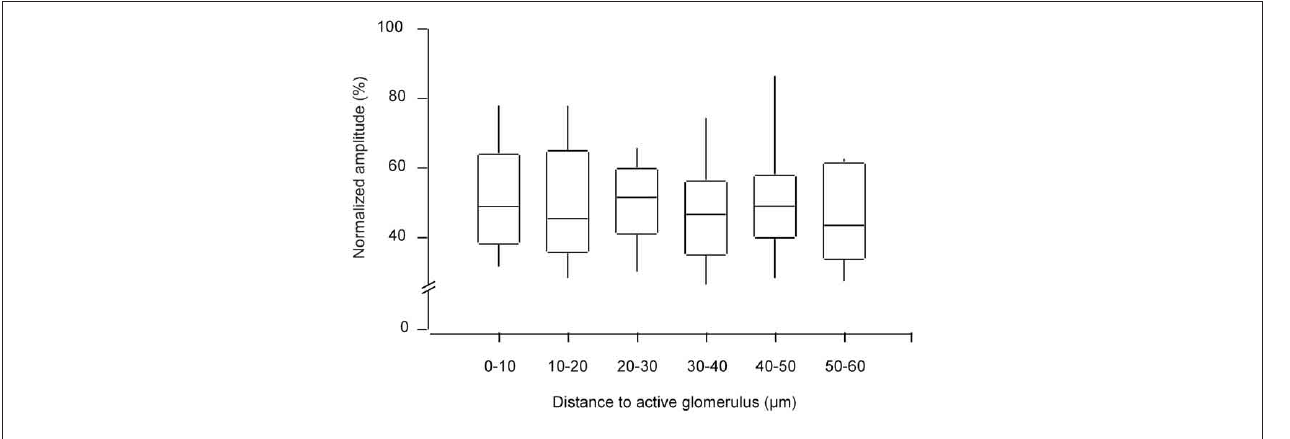
FIGURE A5 | The amplitude of odorant-evoked signals in the responding cells vs. the distance to the active glomerulus. Box-Whisker-Plot illustrating the distribution of normalized amplitudes of odor-evoked Ca 2 + transients plotted with respect to the distance of